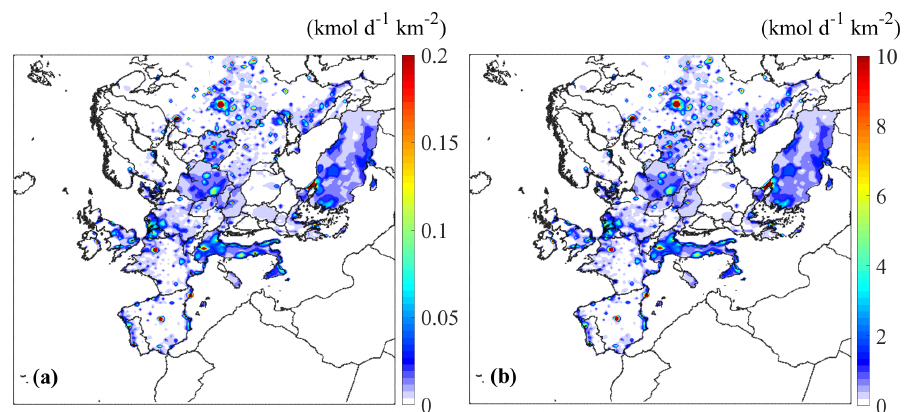
Figure 1. Estimated spatial distribution of the averaged emissions from on-road vehicles of (a) n -dodecane and (b) ALK6 for May 2008.